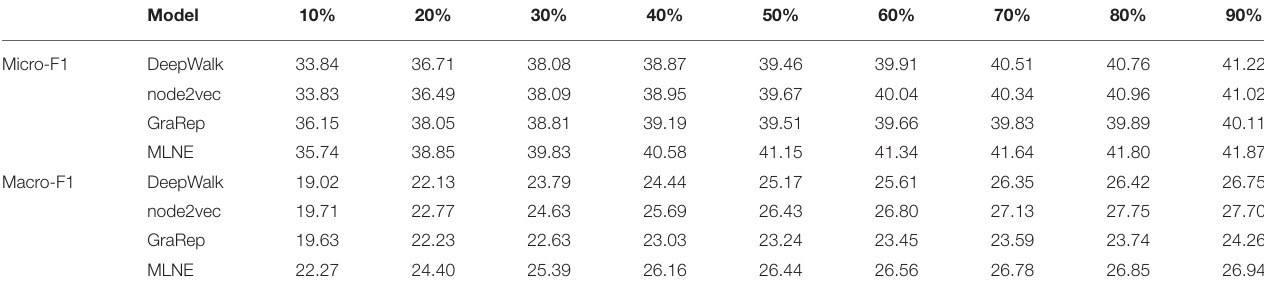
TABLE 5 | Node classification results on Blogcatalog.